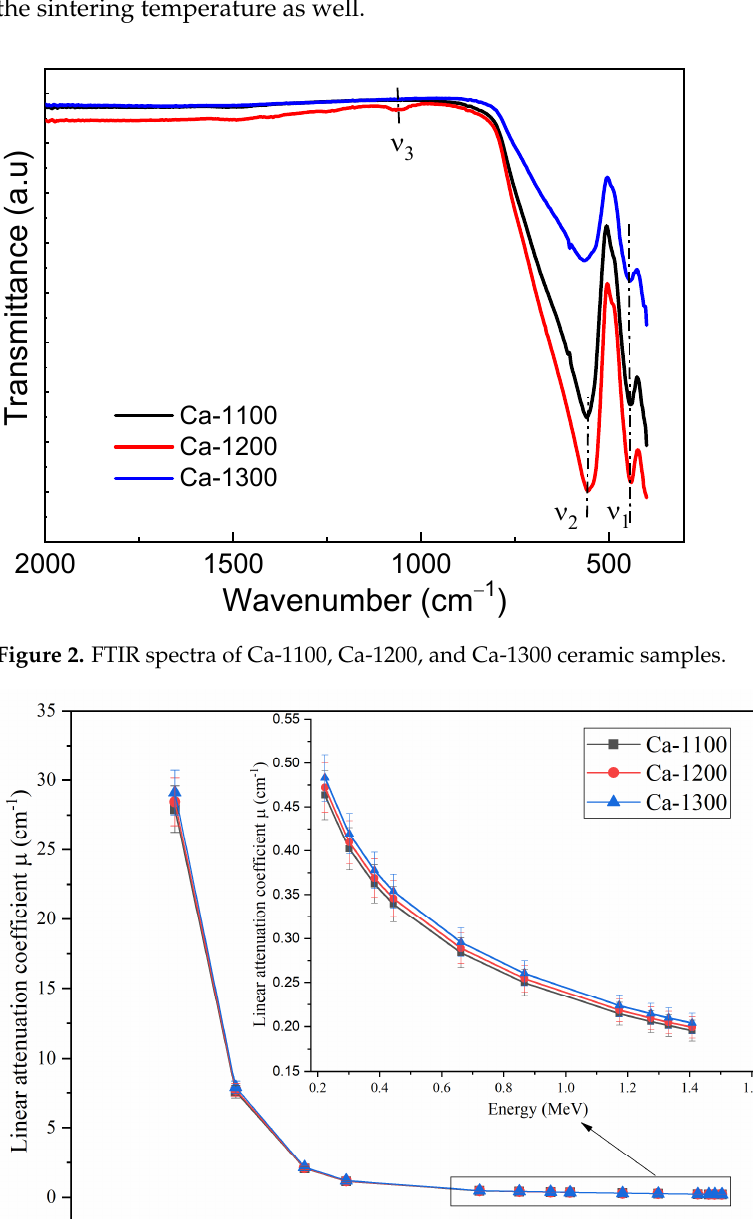
Figure 4. Dependence of the µ values on the temperature. 3.3.2. Half-Value Thickness (Δ 0 . 5 ) The Δ 0 . 5 (Δ 0 . 5 , cm) is the parameter describing the thickness of the ceramic able to shield half of the incident γ-photons. In this study, the Δ 0 . 5 values were affected by the energy and the sintering temperature. The obtained results show that the high γ-photon energies required a larger thickness of the synthesized ceramic samples while the lower γ-photon energies less than 0.081 MeV required several micrometers from the fabricated ceramics to shield half of the incident photons. On the other hand, the intermediate γ-photon energies between 0.1 and 1.4 MeV required Δ 0 . 5 values between 1 and 3.5 cm. The increase in Δ 0 . 5 values is correlated to the reverse relation between the Δ 0 . 5 and the µ